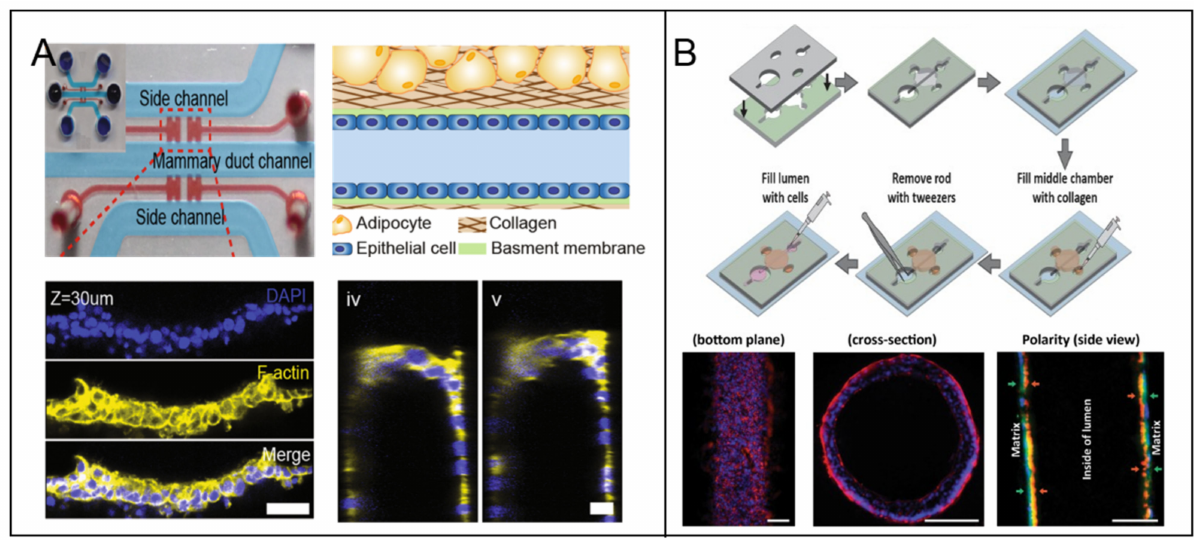
Figure 3. The lumen models in breast tumor-on-a-chip. ( A ) A stable hemi-channel mammary duct was formed on the spatially modified COL1 hydrogel under optimized coating condition. [37] Open access. ( B ) A mammary duct was fabricated on an extracellular matrix (ECM) lumen hollow, which was fabricated by presetting and pulling out of a polydimethylsiloxane (PDMS) rod [41]. Open